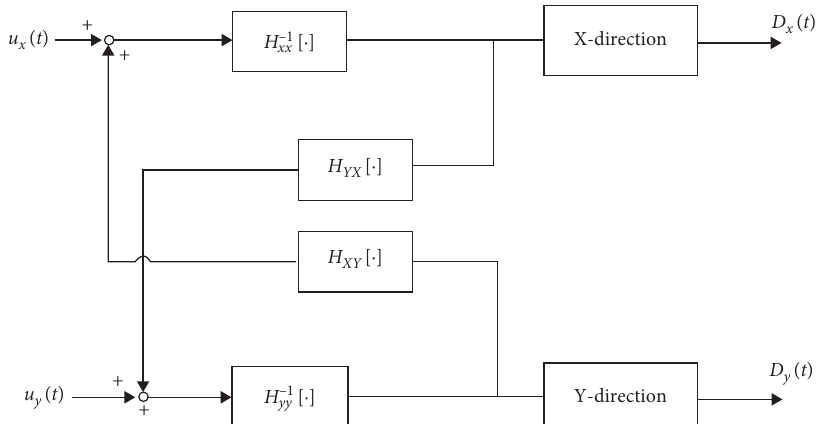
Figure 7: Block diagram of the coupled hysteresis compensation based on the decoupling control system for an XY compliant